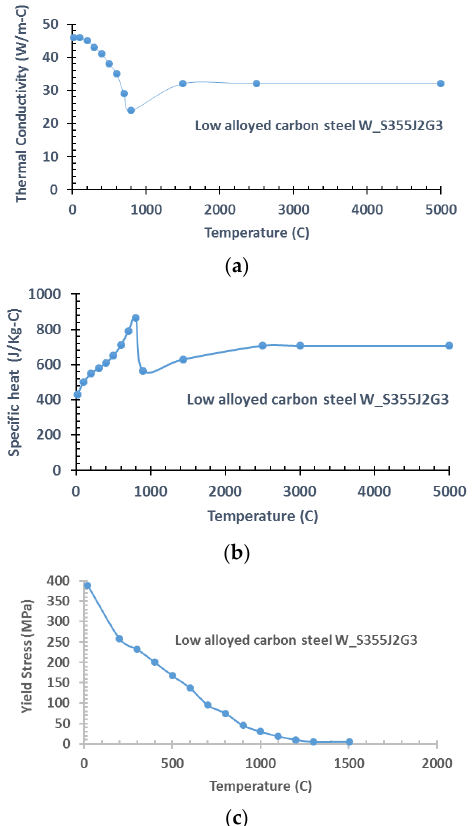
Figure 1. Properties of the SAE-AISI 1524 carbon steel: ( a ) thermal conductivity, ( b ) specific heat, ( c ) yield stress. Using the welding parameters documented in Table 1, a weld was deposited in a SAE-AISI 1524 carbon steel plate. The distribution parameter C was selected from an experimental measurement of the fusion zone width. Cross-sectional metallographic melting temperature profiles were identified. The distribution and shape of the heat input from the heat source largely depends on its value. From there, a 3D transient-nonlinear thermomechanical analysis was carried out to determine the distribution of temperature and residual stresses during the entire welding and cooling cycle. The values of thermal efficiency, forced heat transfer coefficient, surface emissivity, and heat transfer coefficient shown in Table 1, were obtained from the literature that is documented in reference [22]. Table 1. Data used in the FE analysis.